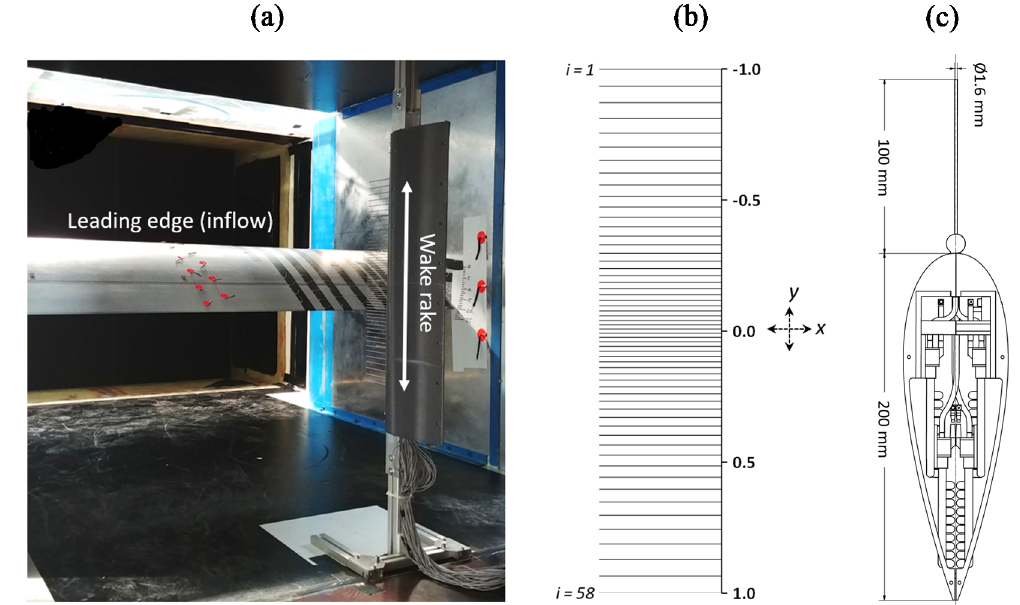
Figure 7. (a) Test section during wind tunnel measurements including airfoil model, one of the end plates and the wake rake. (b) Normalized vertical rake tube positions, y , and numbering, i , in side view. (c) Cross section of wake rake casing and pressure tube in top